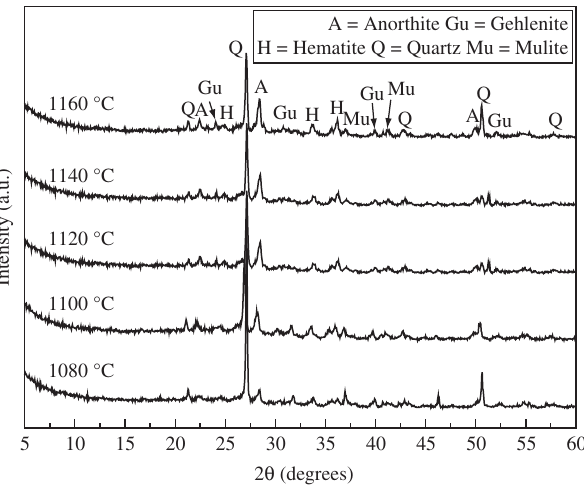
Figure 3. X-ray diffraction patterns of the ceramic paste after sintering at various